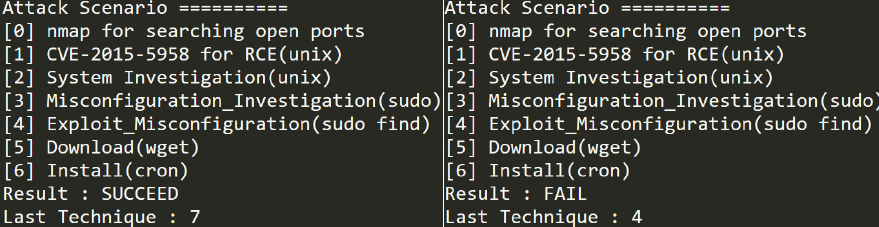
Figure 19. The success (left) and the failure (right) of the red team agent’s attacks exploiting CVE-2015-5958 and misconfiguration of sudoers on the